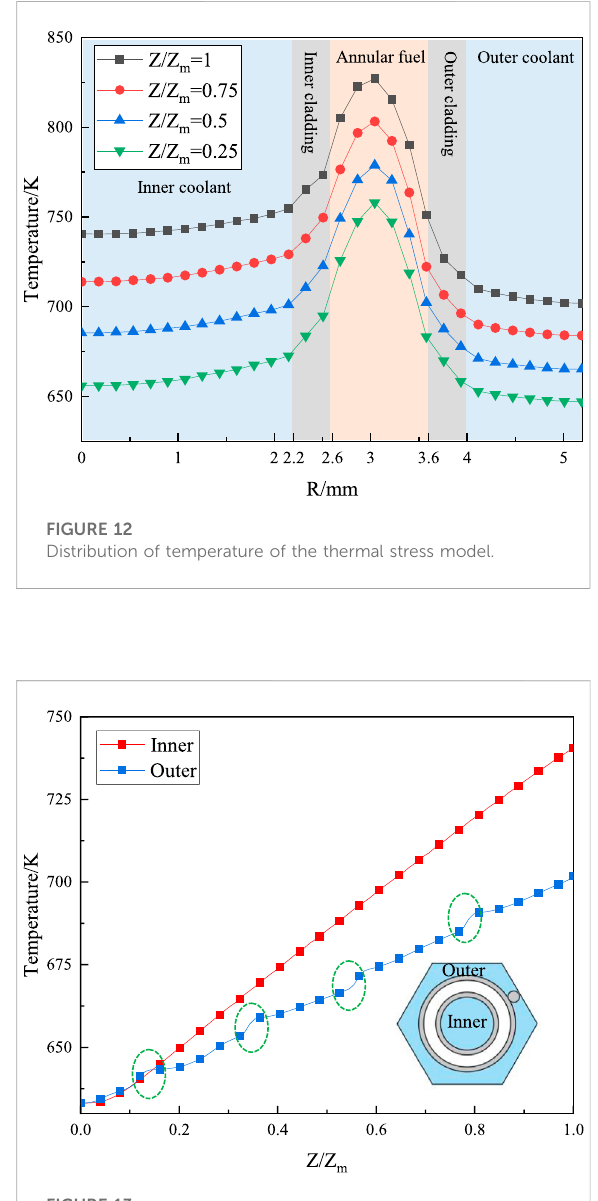
FIGURE 13 Distribution of temperature with inner and outer.